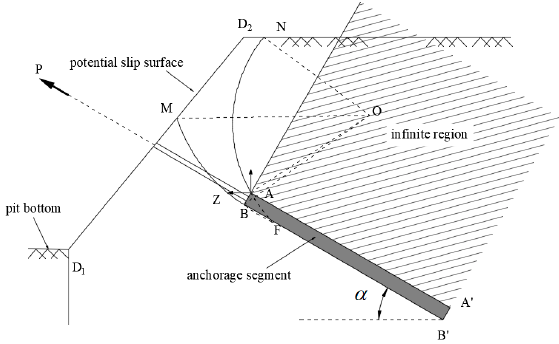
Figure 4. The possible region of rotating center O.